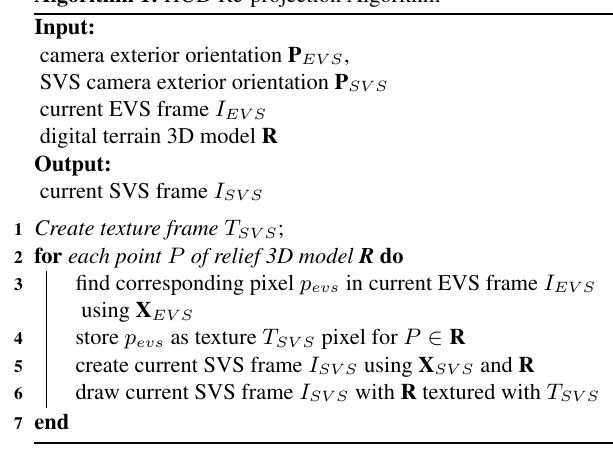
Algorithm 1: HUD Re-projection Algorithm